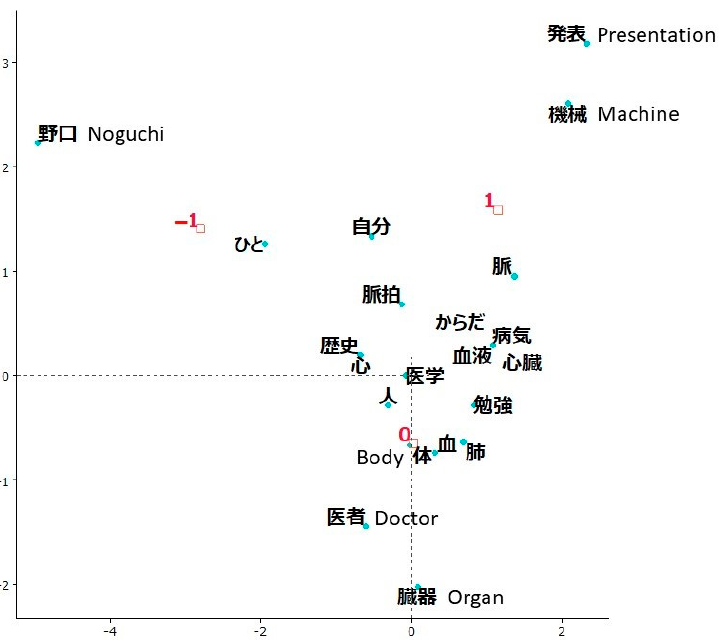
Figure 3. Correspondence analysis of words used in students’ opinions about the BODY workshop depending on changes in the evaluation indicator rating. The group with an increased rating of